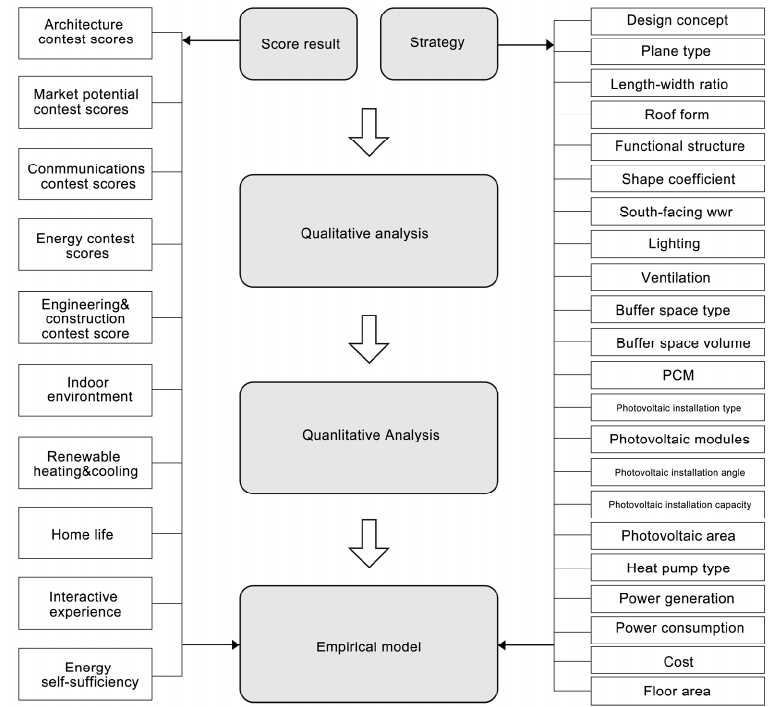
Figure 3. Research